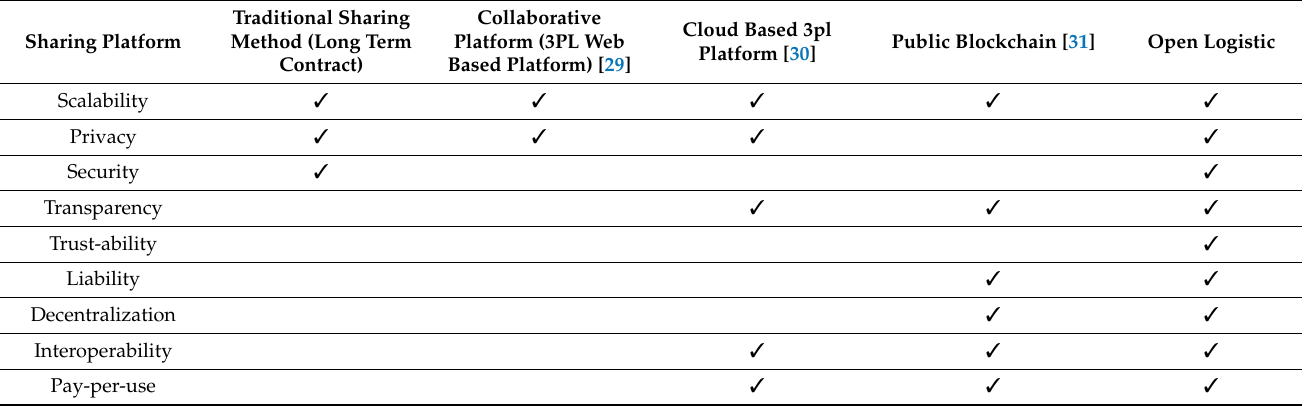
Table 4. The typical comparisons with the existing and currently used platform in qualitative method .